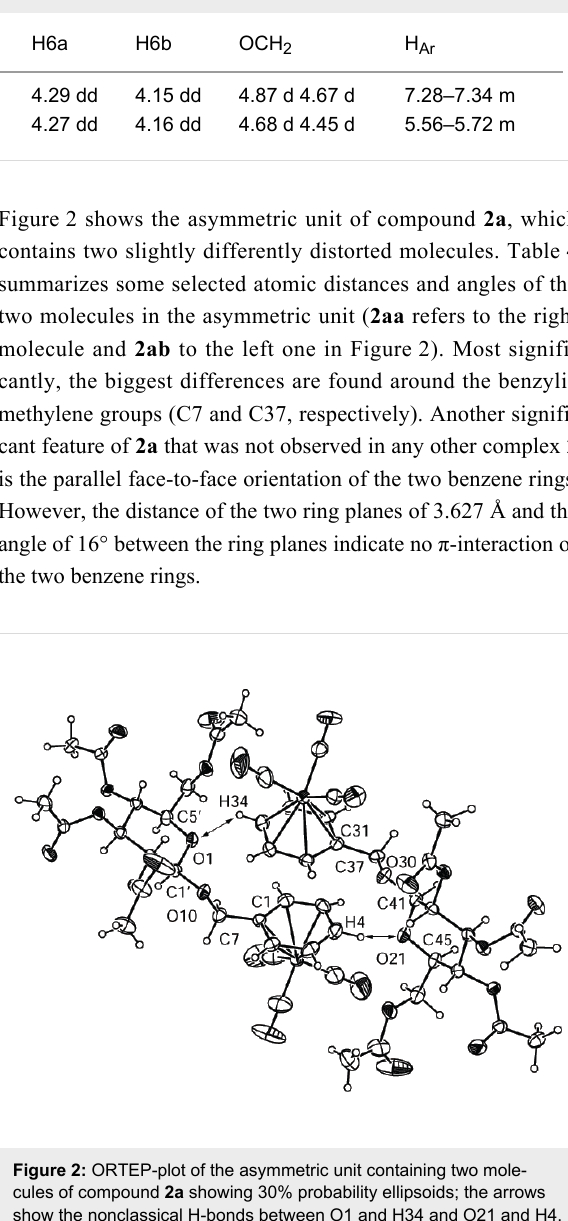
Table 3: Chemical shifts ( δ in ppm) of the protons of compounds 1a and 2a derived from the 1 H NMR spectra of the compounds measured in acetone- d